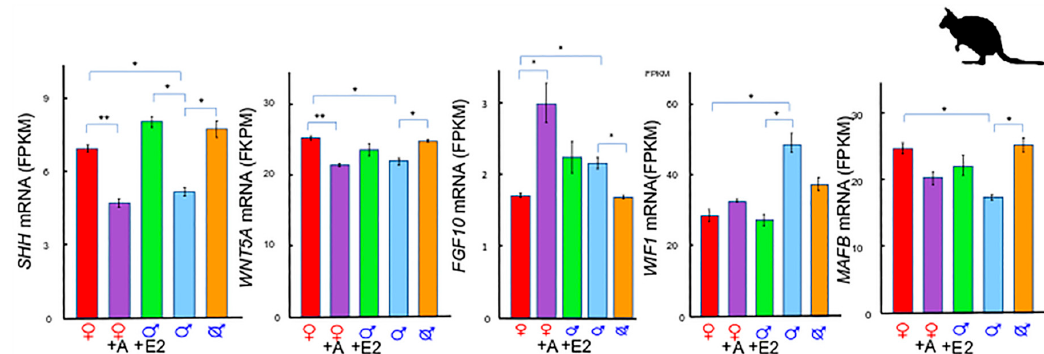
Figure 2. Gene expression of SHH , WNT5A , MAFB , FGF10 , and WIF1 in phalluses at day 50 pp. SHH , WNT5A , and MAFB expression is higher in female phalluses and increases in male phalluses after castration. SHH is upregulated by oestrogen treatment in males but downregulated in females after adiol treatment. WNT5A is downregulated in females after adiol treatment. Both FGF10 and WIF1 are higher in male phalluses at day 50 pp. FGF10 is upregulated by adiol treatment and WIF1 is downregulated by oestrogen treatment. A: adiol, E: oestrogen, *: p -value < 0.05, **: p -value < 0.005, SEM: Standard error of the mean (error bar), Red: control female phalluses, purple: adiol treated female phalluses, green: oestrogen treated male phalluses, blue: control male phalluses, and orange: male phalluses with testes removed (male symbol with a cross). Figure redrawn from [13,16].